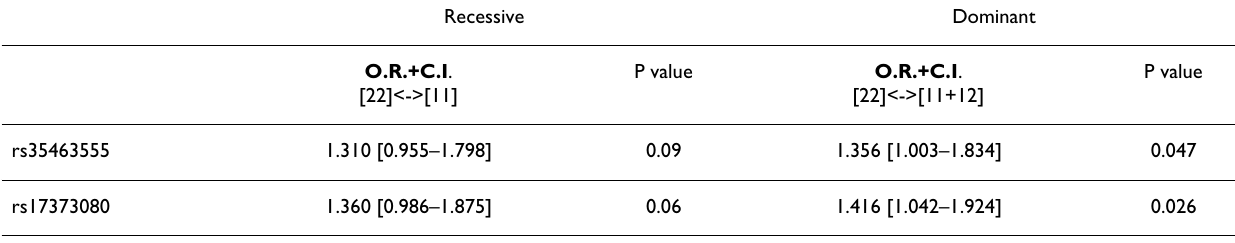
Table 2: Association of LXRB promoter SNP genotypes with T2D in the French cohort